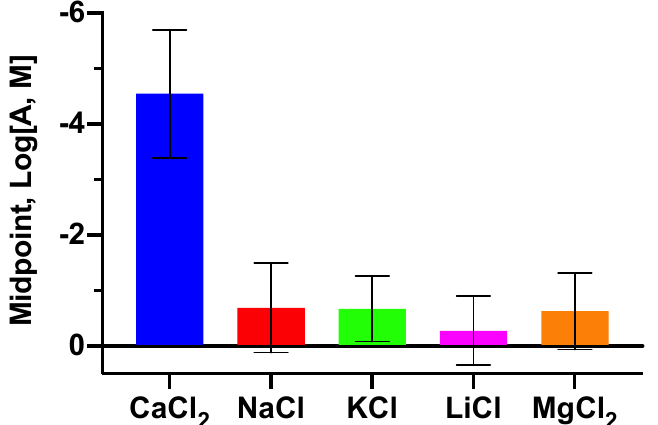
Figure 4. LipiSensors are selective for measuring Ca + 2 over other analytes ( n = 3). Midpoint response versus potentially competing ions.